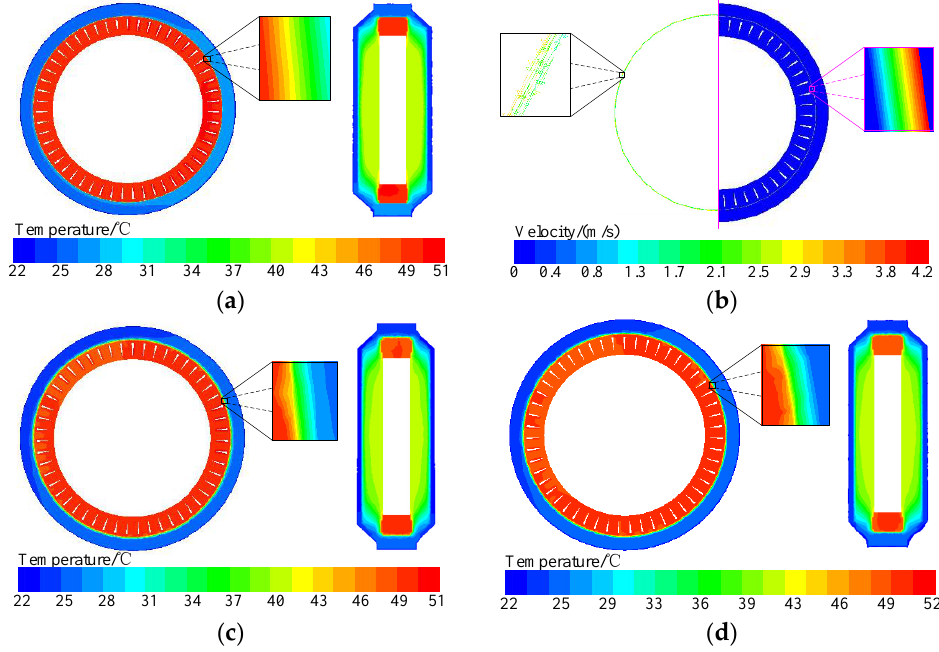
Figure 6. Temperature distribution and velocity distribution of the middle cross-section: ( a ) temperature contour map of the coupled field method (CFM); ( b ) velocity distribution of the air-gap of the CFM; ( c ) temperature contour map of the new method; ( d ) temperature contour map of the conventional method.